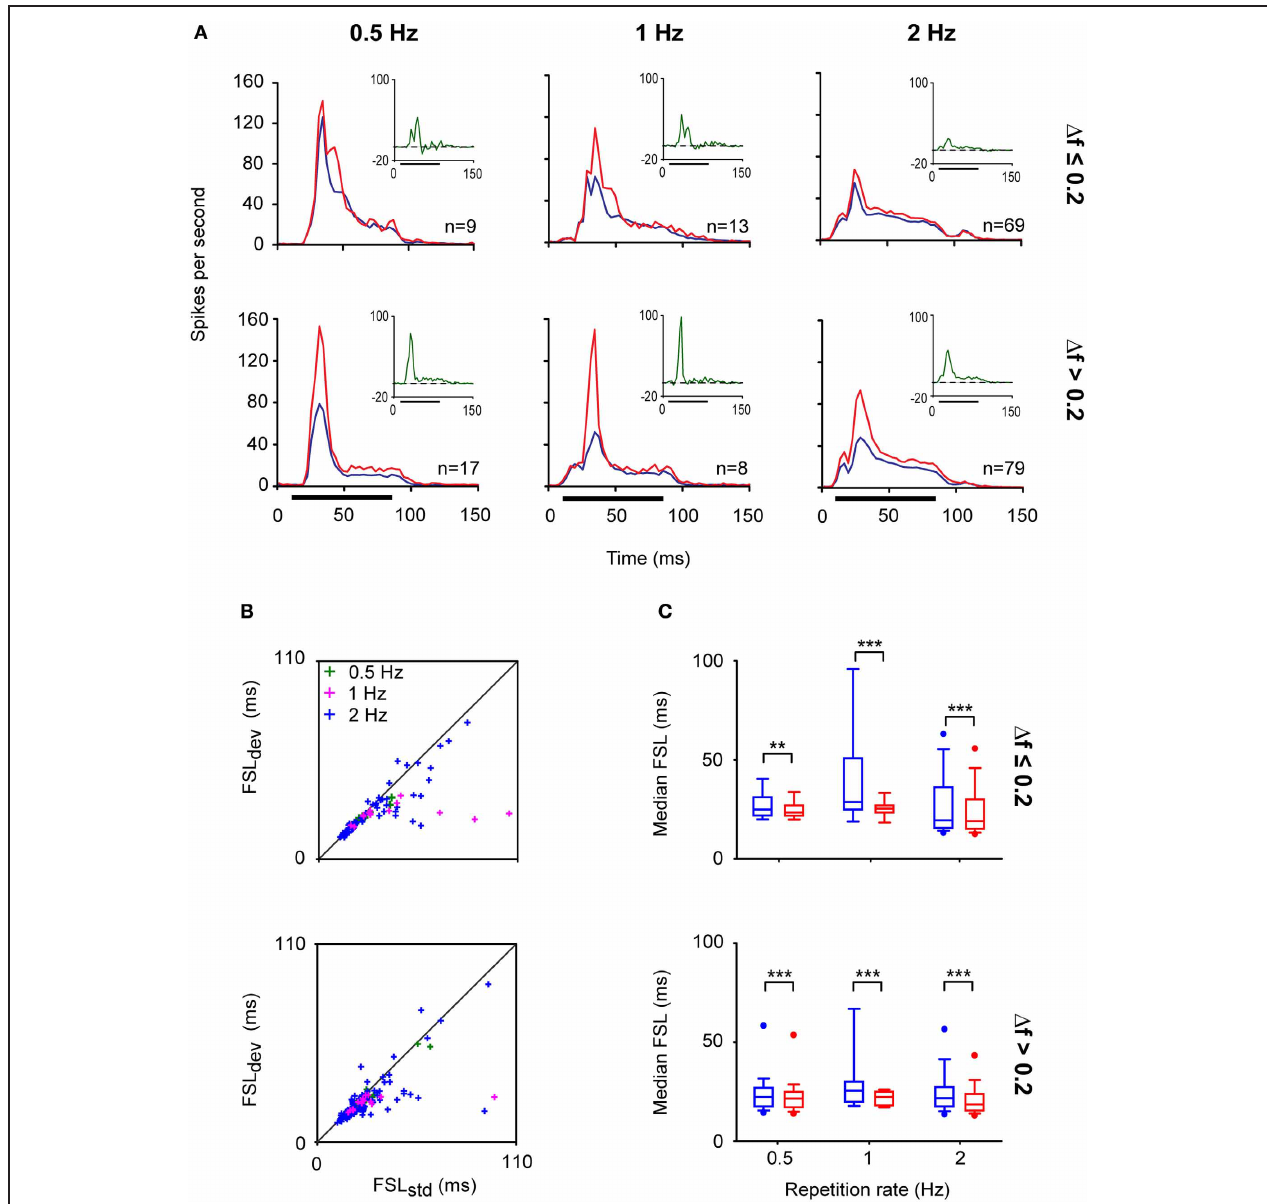
FIGURE 5 | IC neurons exhibit SSA even at very low repetition rates. (A) Population PSTHs of the IC neuronal responses to a deviant (red line) and to a standard (blue line) stimulus presented at different repetition rates; 0.5 (ISI = 2000ms), 1 (ISI = 1000ms), and 2Hz (ISI = 500ms). The physical separations between frequencies were grouped into (cid:2) f ≤ 0 . 2 ( ≤ 0.288 octaves) (top panels) and (cid:2) f > 0 . 2 (bottom panels). The firing rates of individual neurons were averaged and normalized to account for the different number of stimulus presentations due to the different probabilities of the tones (deviant; 10%, standard; 90%). The insets shown in the right upper quadrants of each graph correspond to the averaged